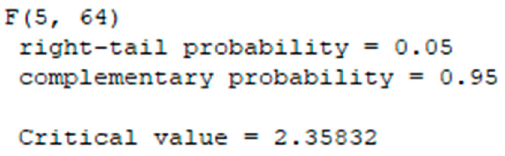
Figure 10. Critical value for Fisher test.